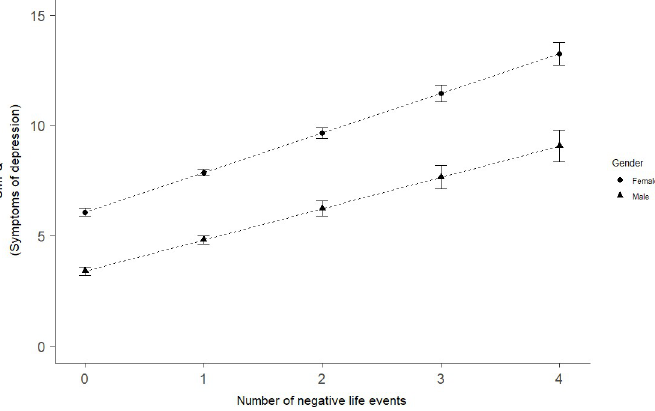
Fig 1. The association between negative life events and symptoms of depression for boys and girls. SMFQ: short moods and feelings questionnaire. Error bars represent 95% confidence intervals.